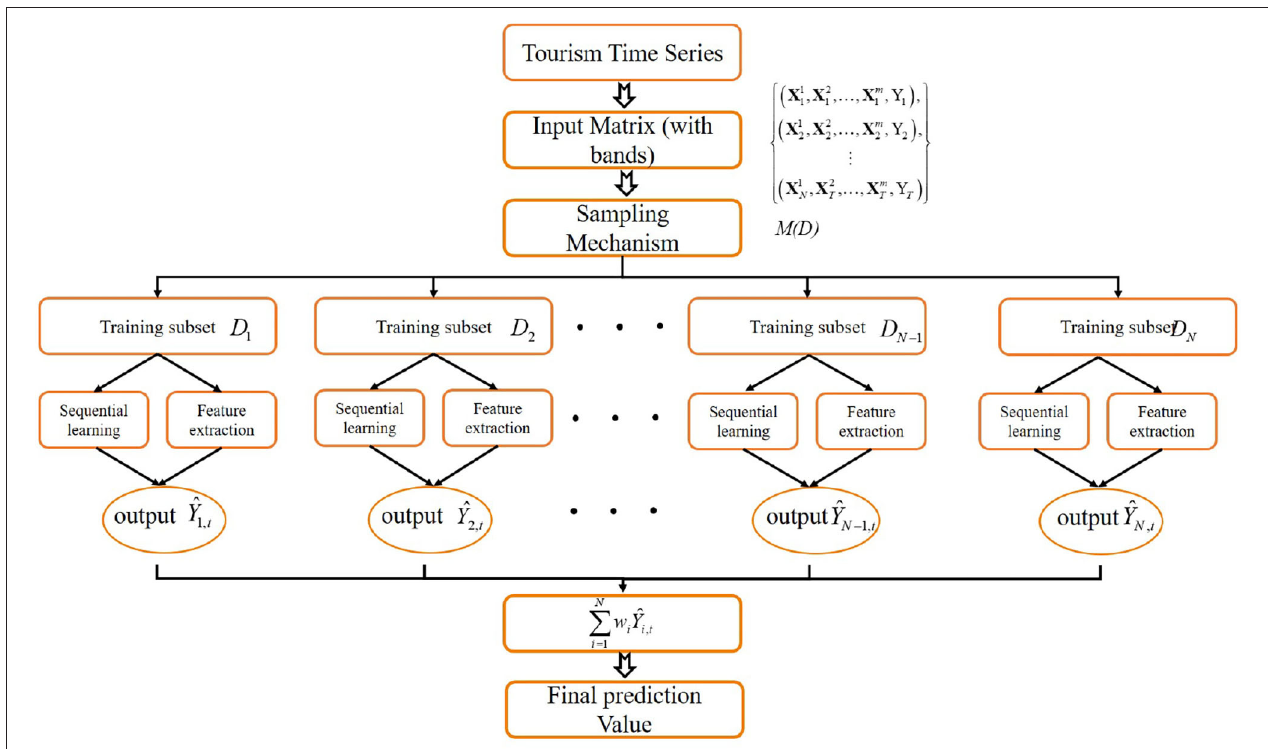
FIGURE 2 | The overview of the proposed ensemble